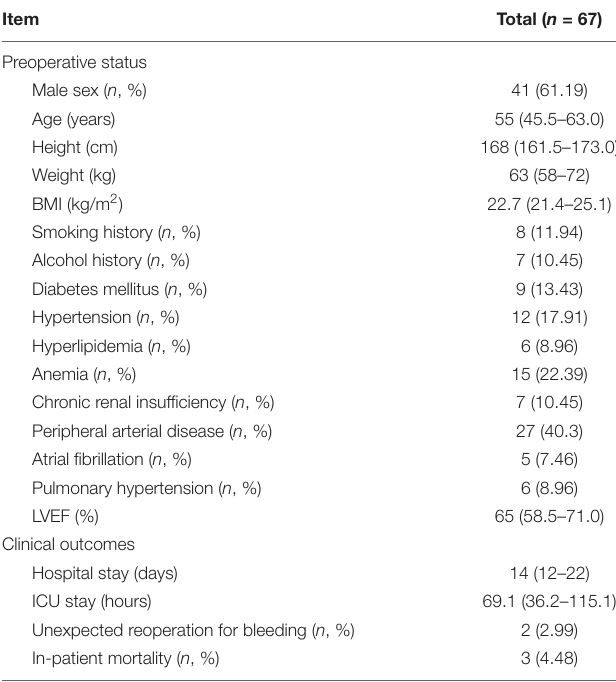
TABLE 1 | Demographic data of study